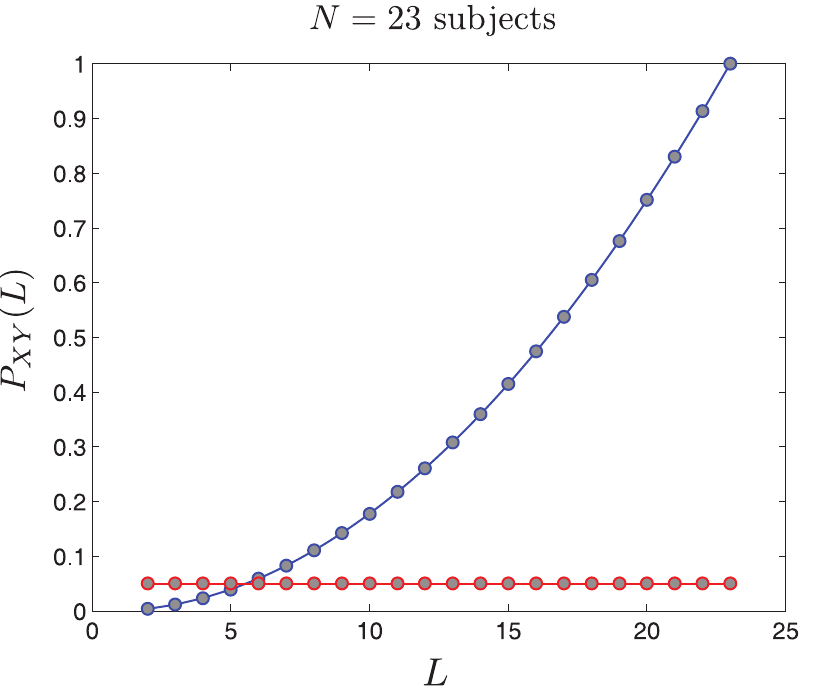
Figure 5. Figure shows a plot of P XY ( L ) vs L for N ~ 23 in blue. The red line shows the a max ~ 0 : 05 cutoff. The largest value of L for which P XY ( L ) ƒ 0 : 05 is L ~ 5 .